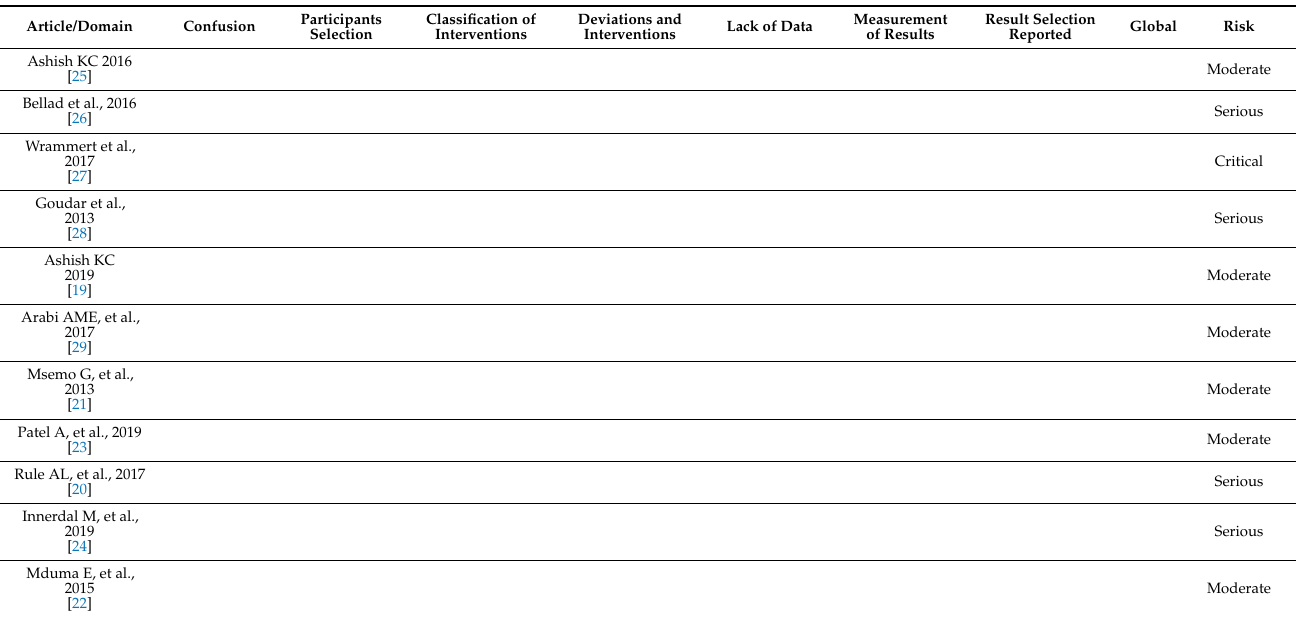
Table 2. Summary of Risk of Bias in Included